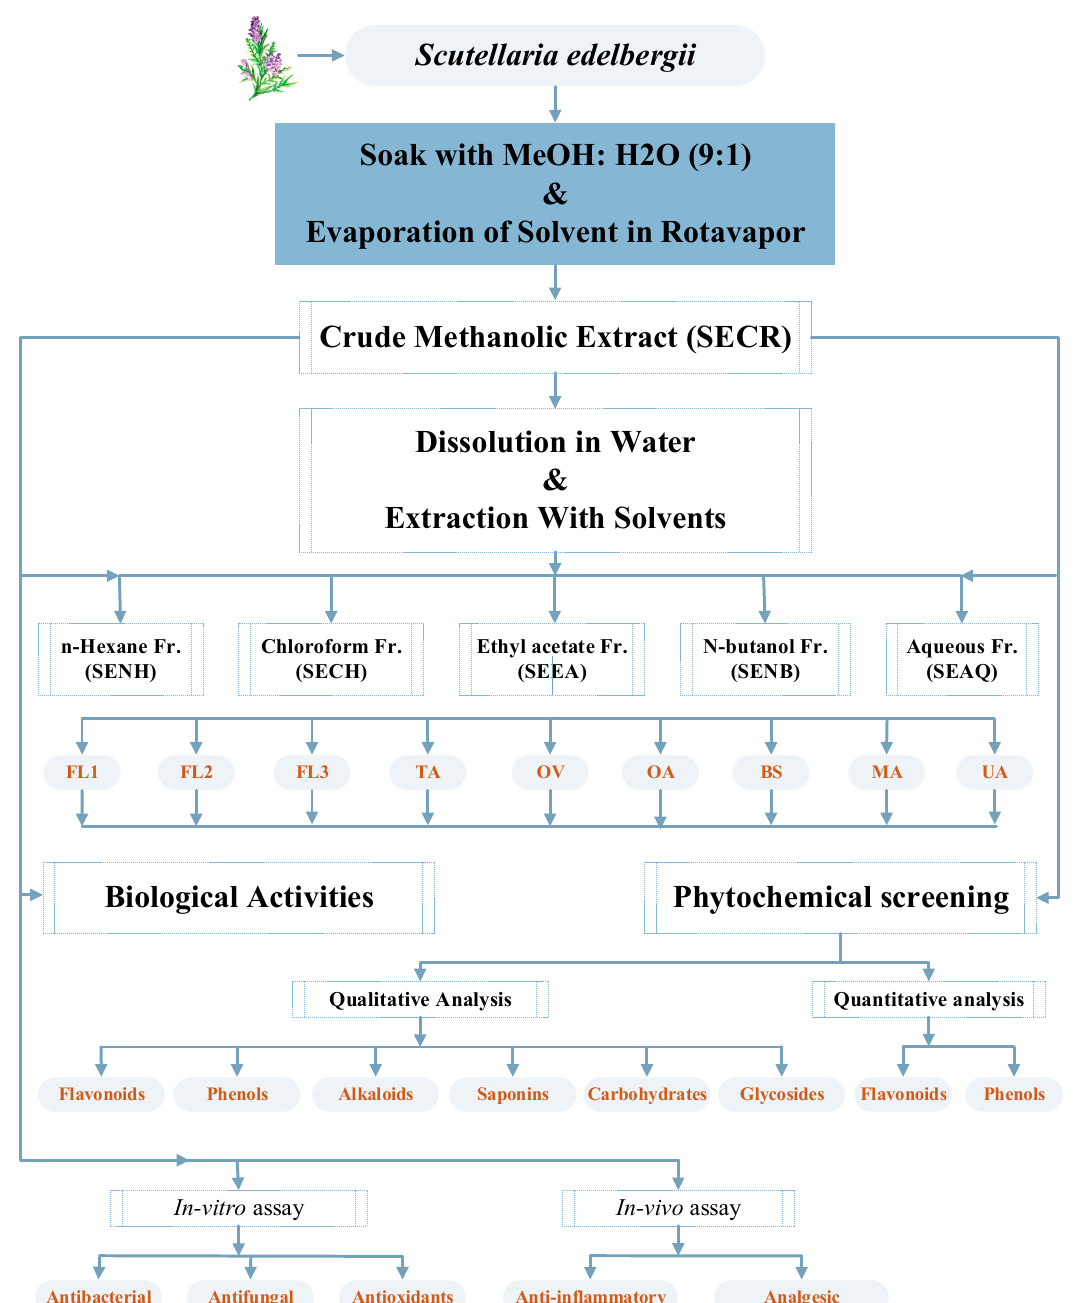
Figure 4. Schematic representation of the current project.